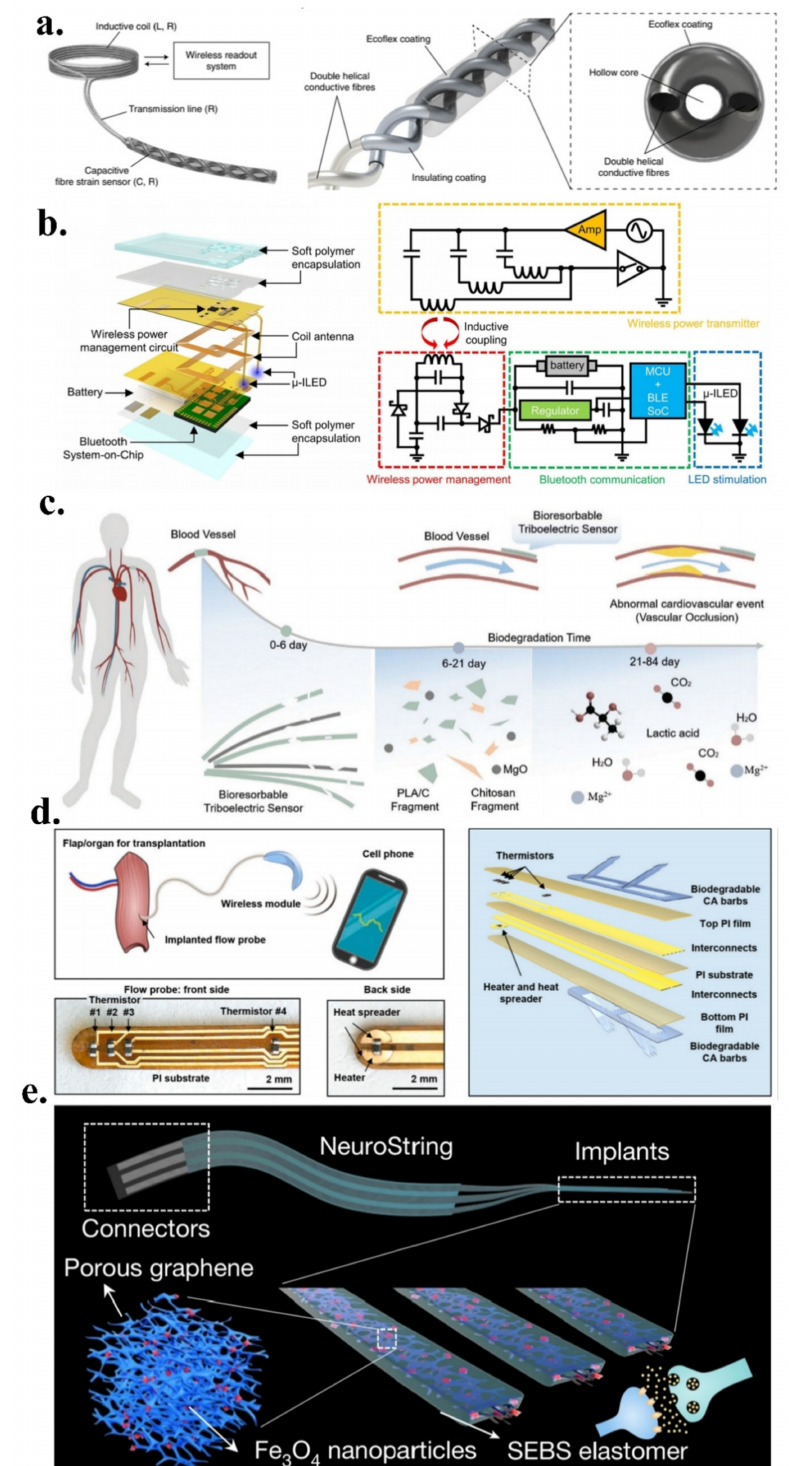
Figure 7. ( a ) Suture–process–connected wireless capacitive fibre optic strain sensor; reproduced with permission from Springer Nature (2021) [124]; ( b ) Wirelessly rechargeable, fully implantable soft opto- electronic system; reproduced with permission from Springer Nature (2021) [133]; ( c ) Biodegradable self–powered pressure sensor; reproduced with permission from Wiley (2021) [136]; ( d ) Wirelessly implantable microflow sensing system; reproduced with permission from Elsevier (2022) [137]; ( e ) Stretchable biological interface for neural tissue; reproduced with permission from Springer Nature (2022)